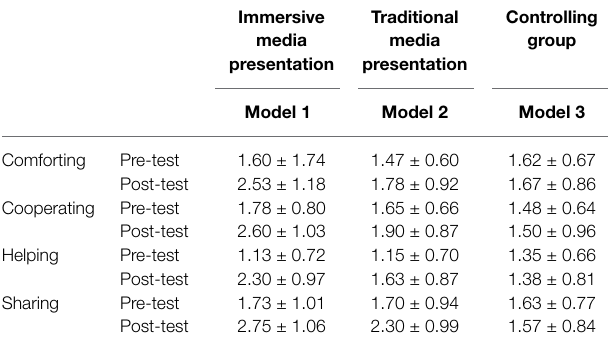
TABLE 1 | Results of the relationship between media presentation and prosocial